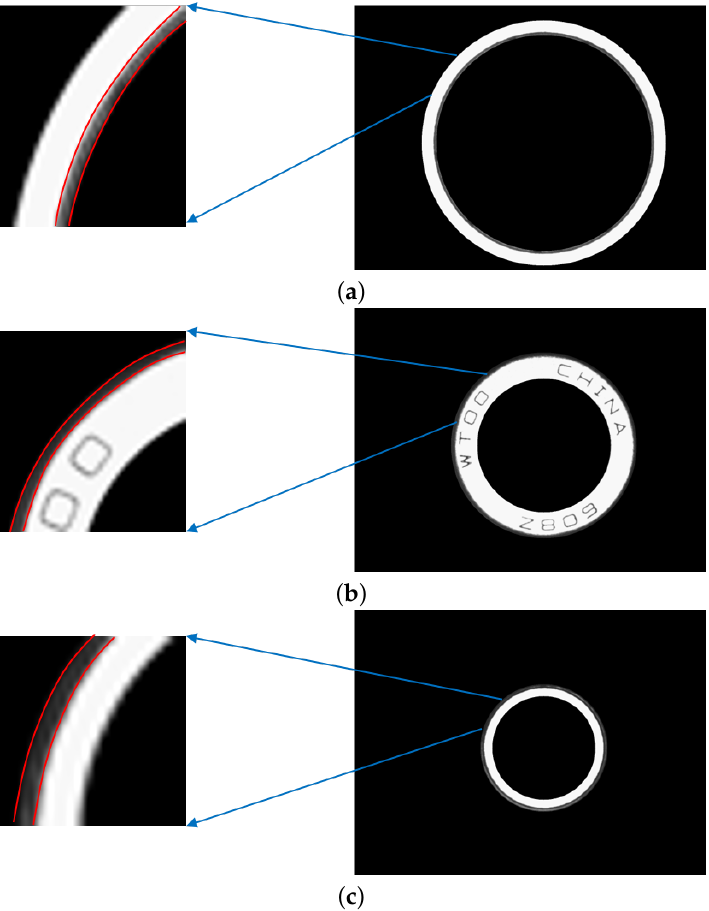
Figure 6. Abnormal dimension instances of outer ring, dust cover and inner ring. ( a ) Abnormal dimension instance of outer ring. ( b ) Abnormal dimension instance of dust cover. ( c ) Abnormal dimension instance of inner ring.